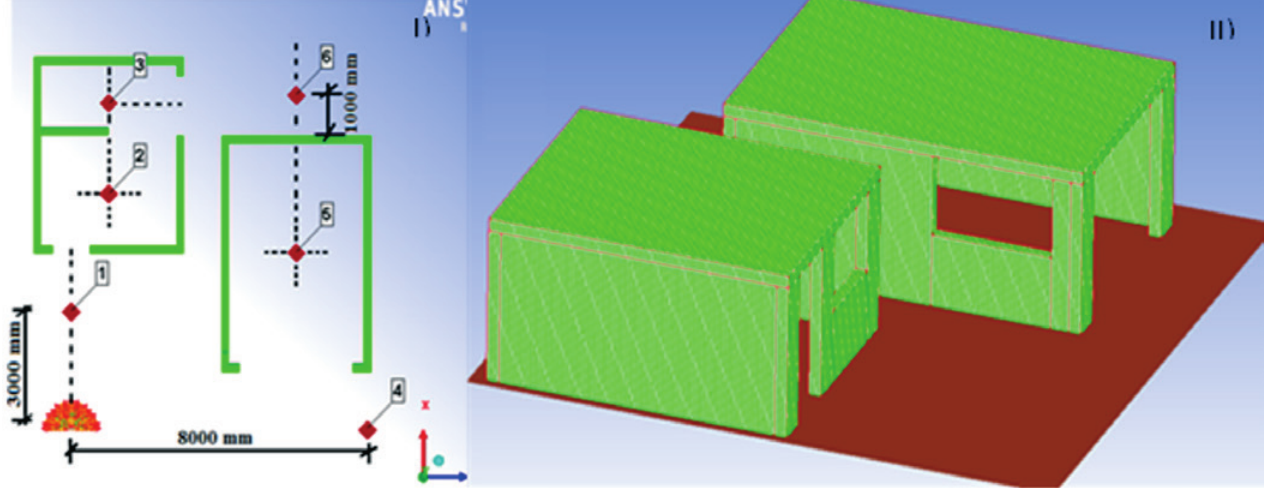
I) Gauges positioning; II) Mesh detail and rigid soil surface